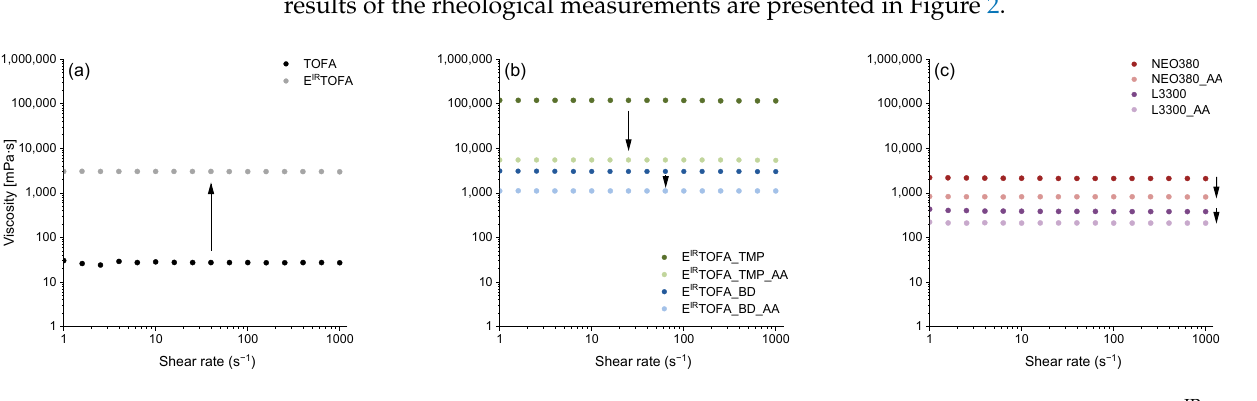
Figure 2. Rheological viscosity versus the shear rate at 25 °C for: ( a ) TOFA and E IR TOFA; ( b ) E IR TOFA-based polyols and their acetoacetates; ( c ) commercial polyols and their acetoacetates.